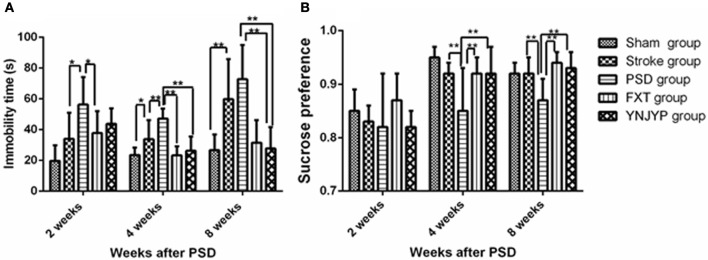
(A) Effect of treatments on the immobility time of PSD rats in the forced swim test. (B) Effect of treatments on the sucrose preference of PSD rats in the sucrose consumption test. Data are presented as mean ± standard error of the mean. n = 6; *P < 0.05, **P < 0.01. Sham group, sham operation group; PSD group, post-stroke depression group; FXT group, Fluoxetine hydrochloride capsules group; YNJYP group, Yi-nao-jie-yu prescription group.